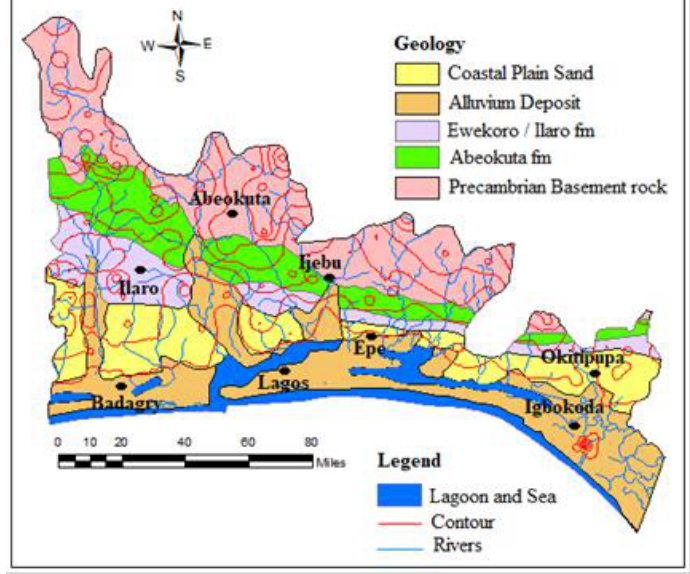
Figure 2. Geological map of Eastern Dahomey Basin.